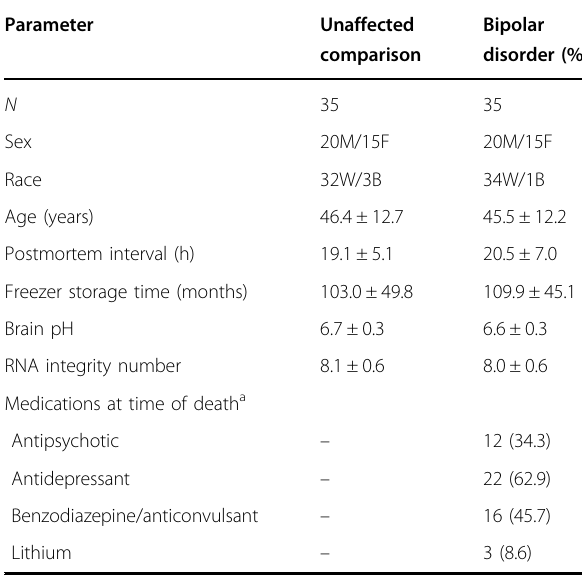
Table 1 Summary of demographic and postmortem characteristics of human